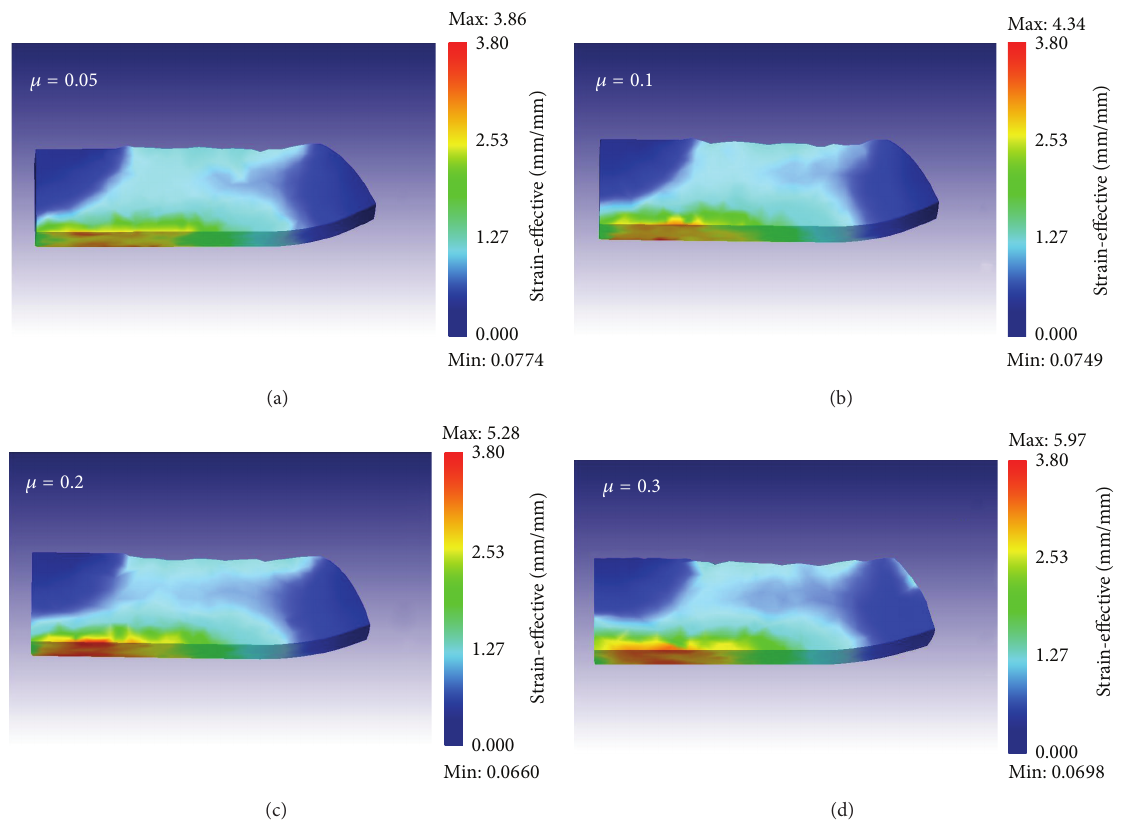
Figure 2: The effective strain distribution of the workpiece after ECAE process with different friction coefficient: (a) 𝜇 = 0.05 , (b) 𝜇 = 0.1 , (c) 𝜇 = 0.2 , and (d) 𝜇 = 0.3 .